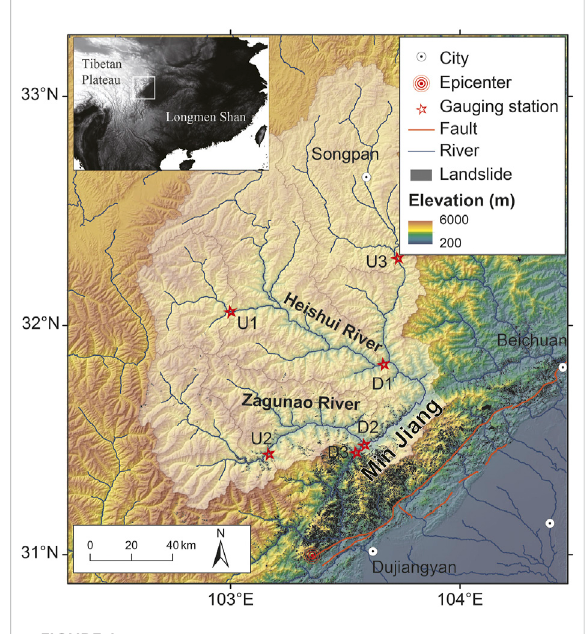
FIGURE 1 Map of sampling locations at the upper Min Jiang, showing the paired upstream (U) and downstream (D) gauging stations (red stars) and landslides (black polygons, after Li et al. (2014) triggered by the 2008 M w 7.9 Wenchuan